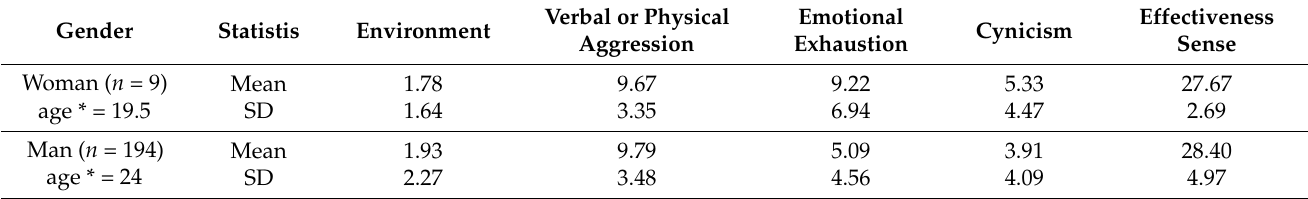
Table 3. Descriptive statistics of each factor depending on their